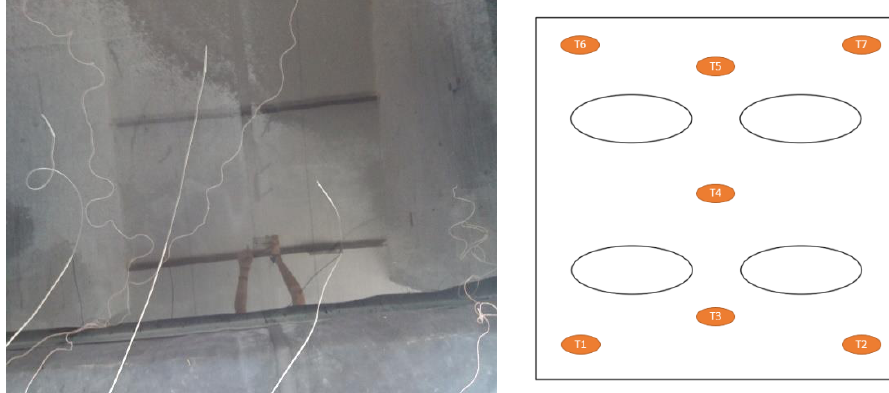
Figure 3. Sensor positions in ponds.